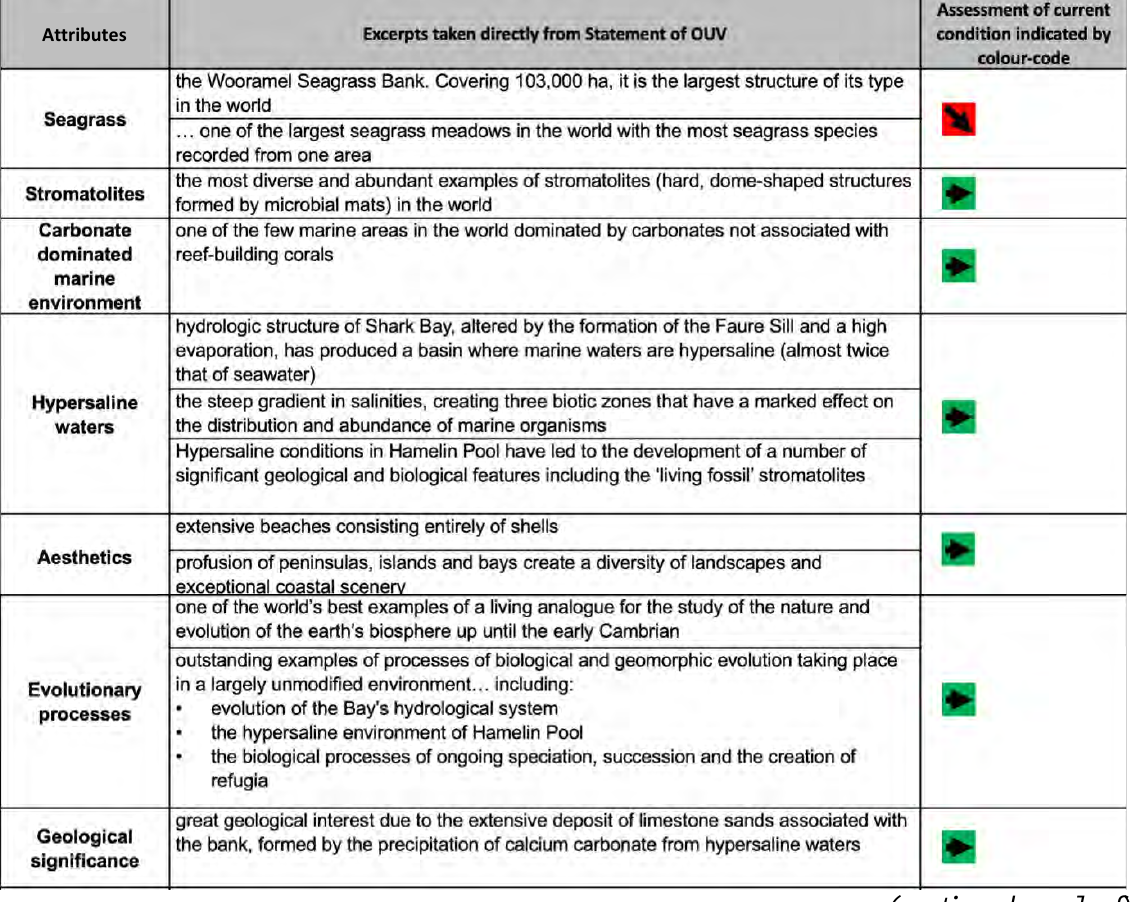
Table 2.1 Attributes for Shark Bay, Western Australia derived from the Statement of Outstanding Universal Value (OUV), together with the assessed current condition and trend since inscription ( legend on p13 ).